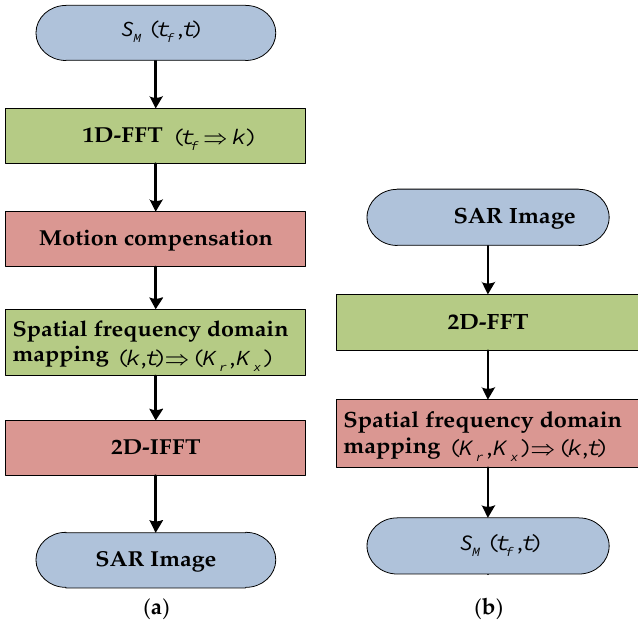
Figure 2. RD and IRD algorithm flow charts. ( a ) RD algorithm flowchart; ( b ) IRD algorithm flowchart.